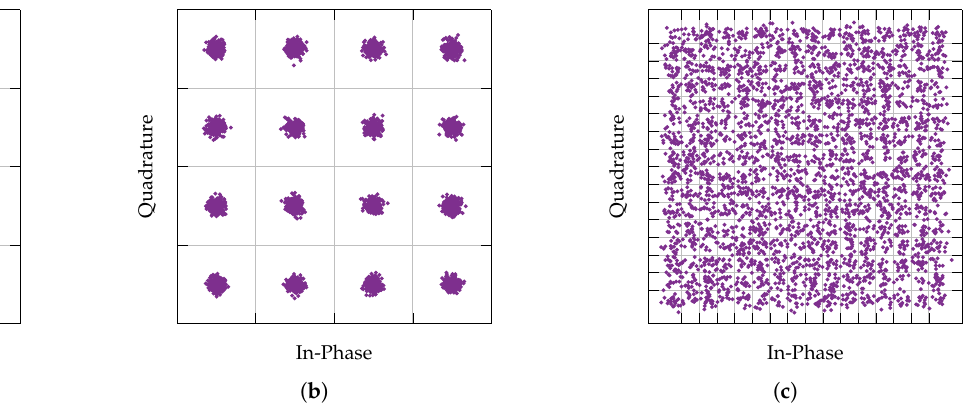
Figure 4. Constellation diagrams showing a reference 16-QAM constellation, and QAM signals with manually added noise. The same number of QAM symbols are tested in each figure. The grid lines depict the relative constellation sector boundaries. ( a ) 16-QAM reference constellation. ( b ) 16-QAM signal with an EVM and BER/SER of 26.4 dB, and 0, respectively. ( c ) 256-QAM signal with an EVM − and BER/SER of 25.6 dB, and 0.10, respectively. −